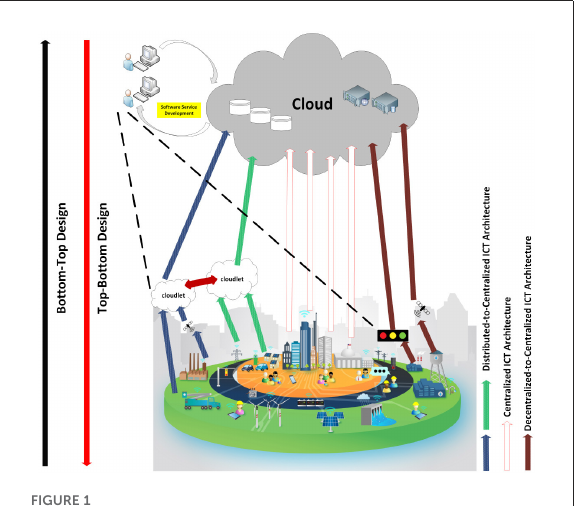
FIGURE1 Different ICT architectures in Smart City for data management, processing, and software services development, extract main idea from Sinaeepourfard (2017), Sinaeepourfard et al.